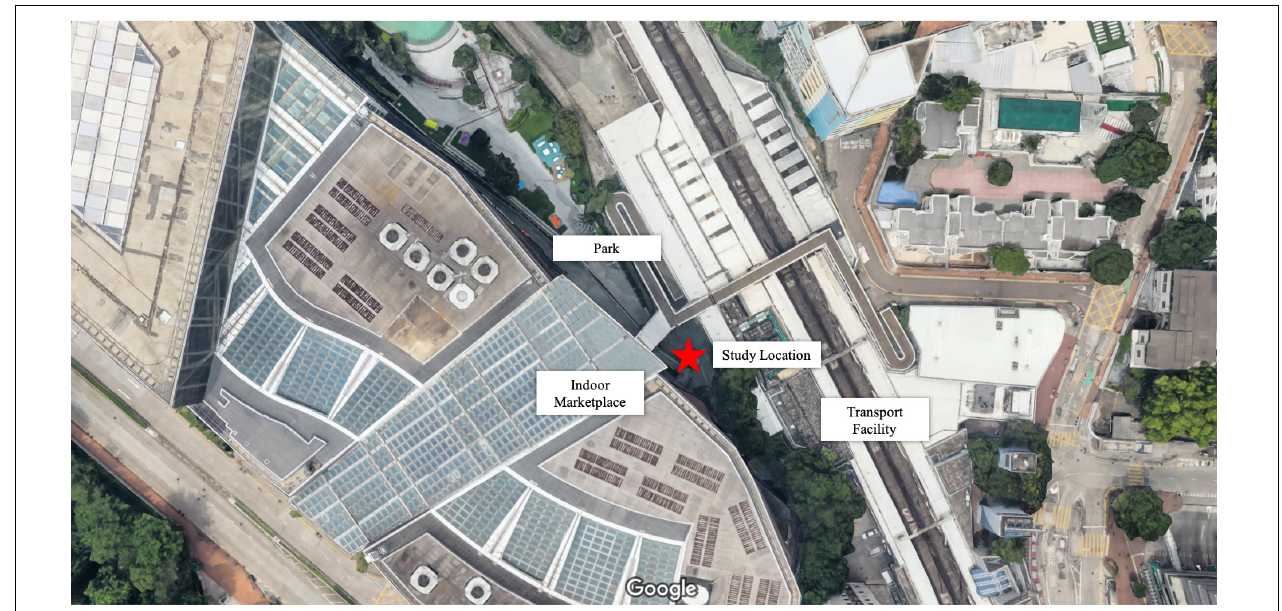
FIGURE 4 | Map view of quasi-experiment location of Study 2.